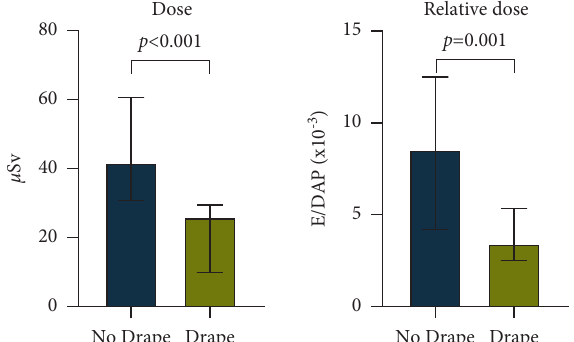
Figure 2: Median operator chest dose and relative operator chest dose normalized for dose area product (x10 − 3 ). Bars represent median values with interquartile